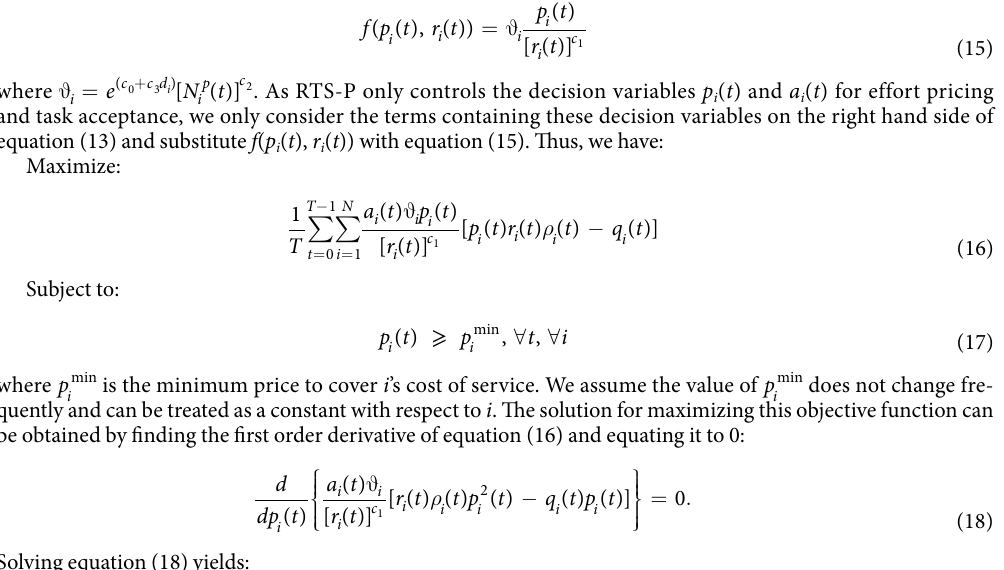
2 . As RTS-P only controls the decision variables p i ( t ) and a i ( t ) for effort pricing and task acceptance, we only consider the terms containing these decision variables on the right hand side of